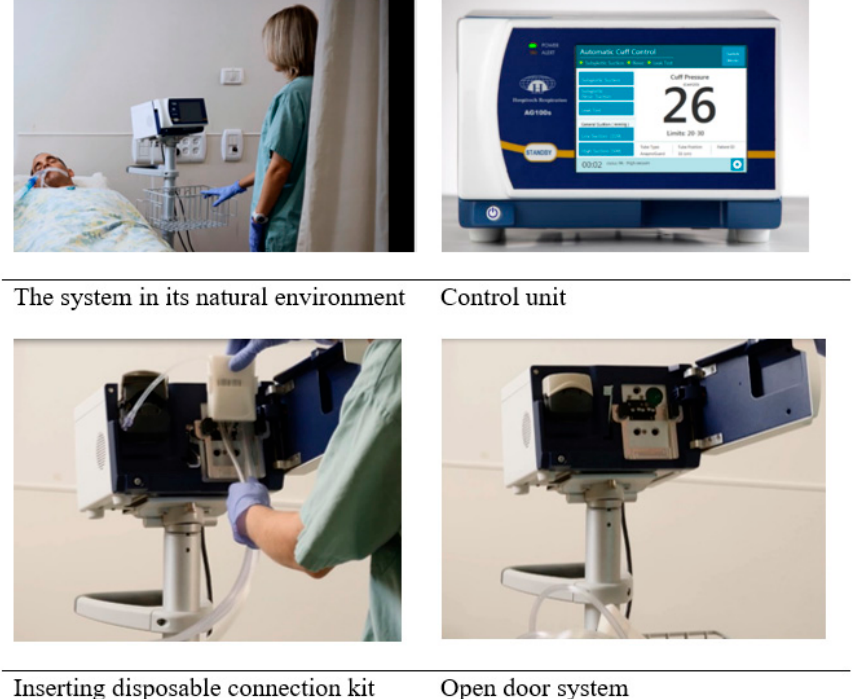
Figure 11. AG100s final design.